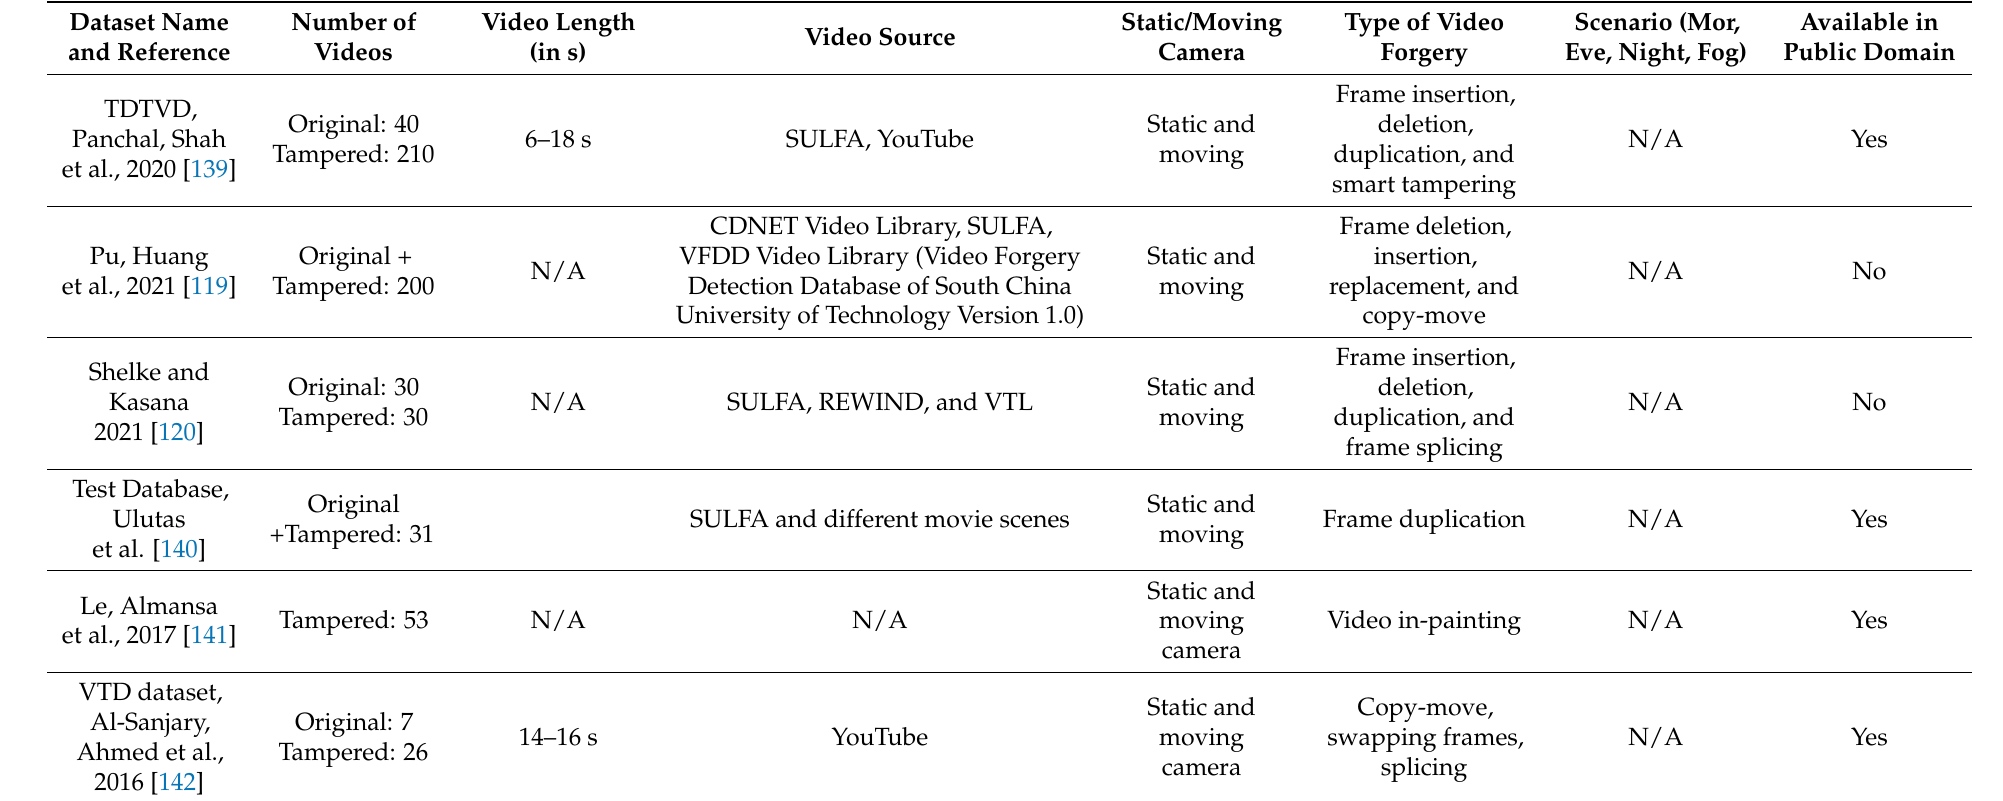
Table 5. Details of existing video forgery